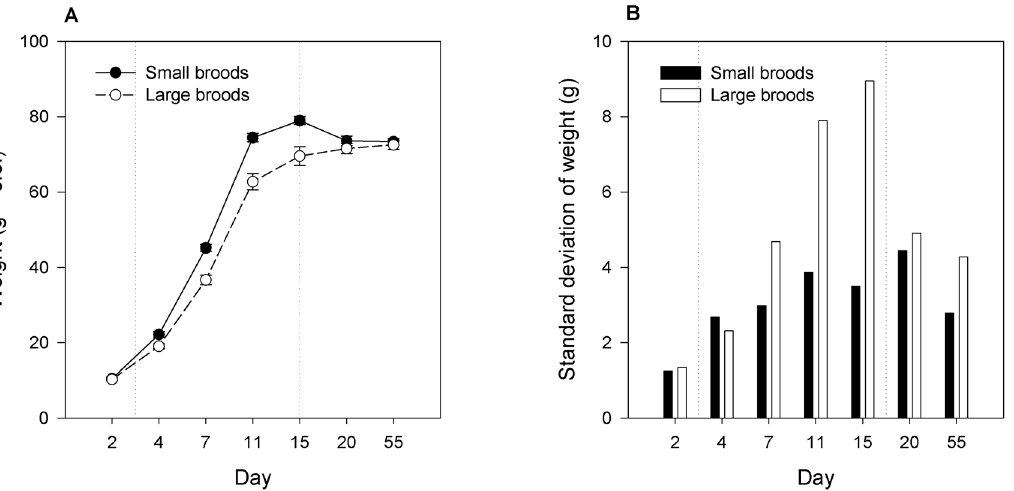
Figure 1. Effects of nestling competition on growth. The vertical lines represent the beginning and end of the period in the experimental broods. A. Means and standard errors for weights over time for birds assigned to large broods (5–7 chicks) and small broods (2 chicks). B. The standard deviations at each time point of the weights of birds assigned to large and small broods.